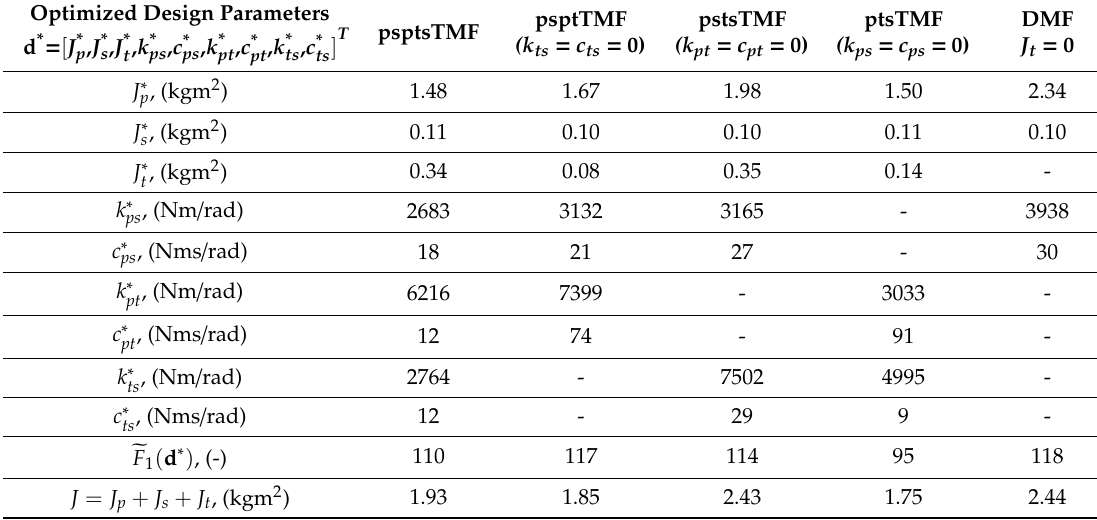
Table 1. Results of the solution of problem weight-vibration Pareto optimization (WV-PO), T m = 300 Nm,